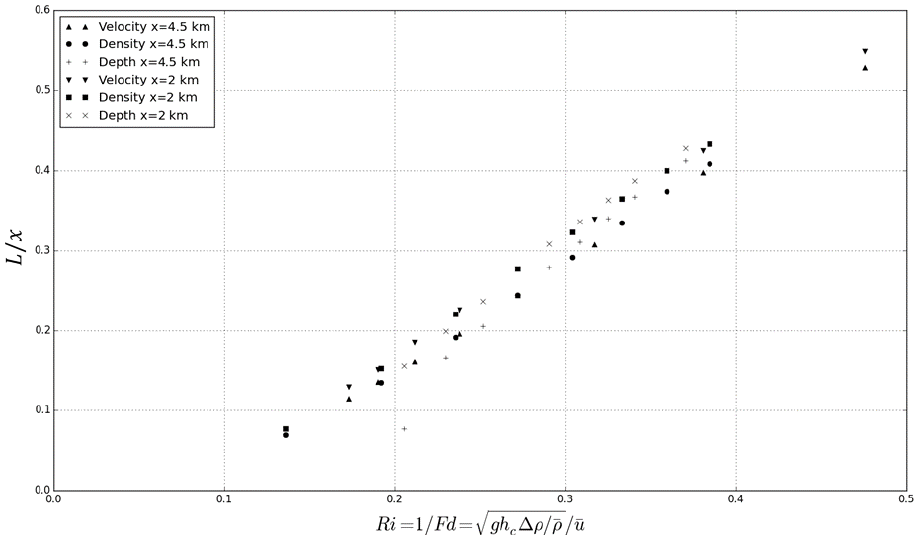
Figure 12. The relationship between the dimensionless amount of overturning and the Richardson number at 2 and 4.5 km downstream of the confluence